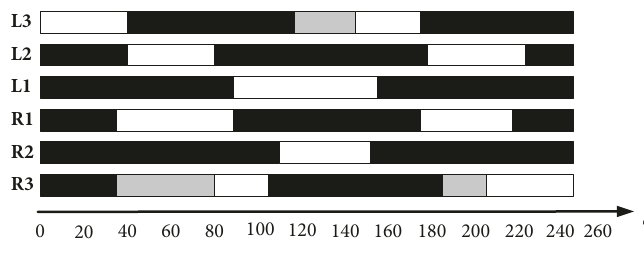
Figure 8: Foothold pattern diagram of the irregular gait.